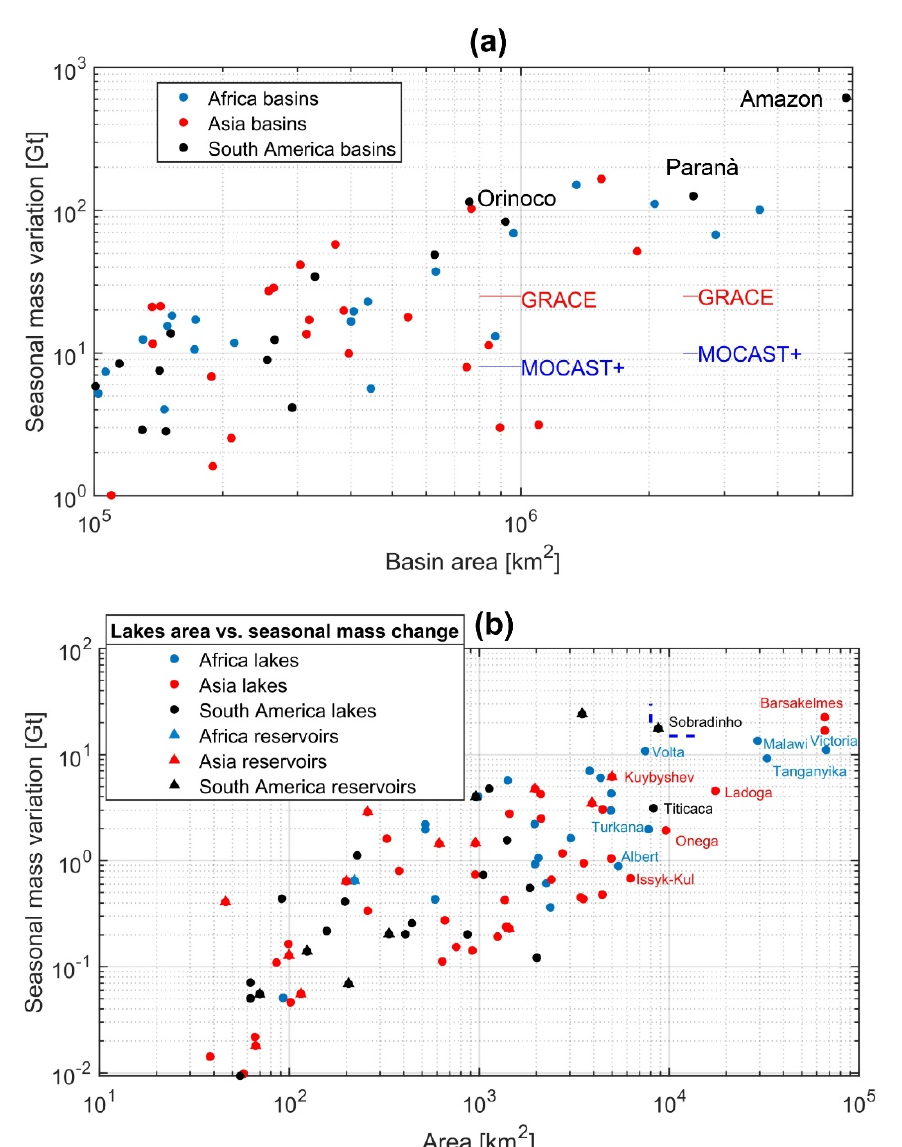
Figure 16. Scatterplot of seasonal hydrologic mass amplitudes for lakes and basins versus area; ( a ) Relation between amplitude of the seasonal mass variation and area of the hydrologic basin. Amazon, Paraná, and Orinoco basins have been labelled. Red and blue lines report the lowest basin detectable by GRACE and MOCAST+: these basins have areal extents similar to the Orinoco but experience lower seasonal mass variations. For GRACE, the detectability level is 25 Gt while for MOCAST+ it is 8 Gt. ( b ) Lakes/reservoirs’ seasonal mass amplitudes as function of area. Different colors for different geographical regions; triangles are artificial reservoirs. Dashed lines (near Sobradinho) bound the detectability area according to our criteria employing a MOCAST+ mission.